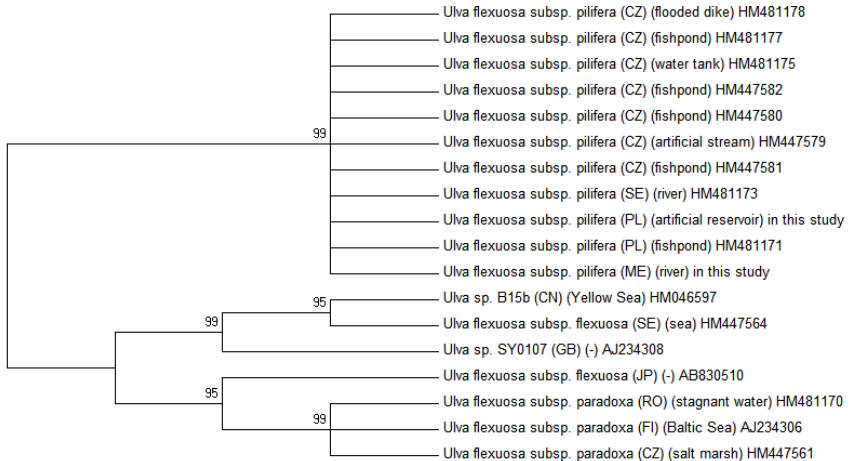
Figure 5. Maximum likelihood of ITS DNA sequences of U. pilifera samples obtained from Montenegro and Poland. Numbers on branches bootstrap support analysis 1000/50. The phylogenetic tree was constructed by the ML algorithm of the MEGA 6 program. Location and habitat of Ulva species taken from GenBank [3,12].